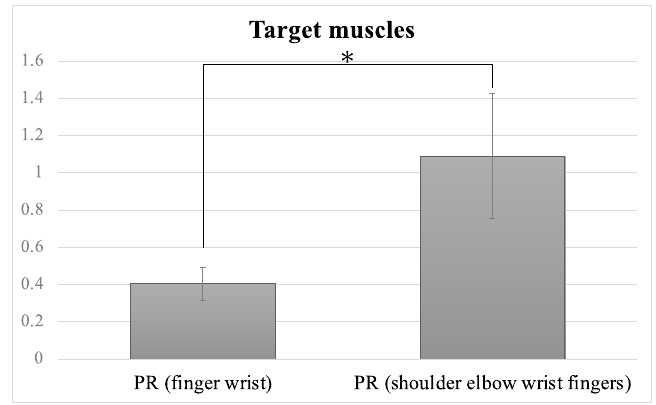
Figure 4. Progress rates (PR) of different target muscles. Error bars indicate standard errors. There was a significant difference between the finger and wrist flexors/extensor group and the whole-UE (shoulder, elbow, wrist, fingers) group. Significant difference is denoted by *.